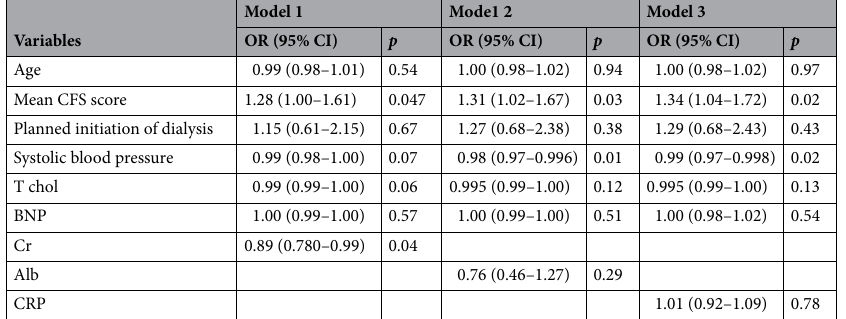
Table 4. Results from multivariate cox proportional hazards model for 2-year mortality or hospitalization.